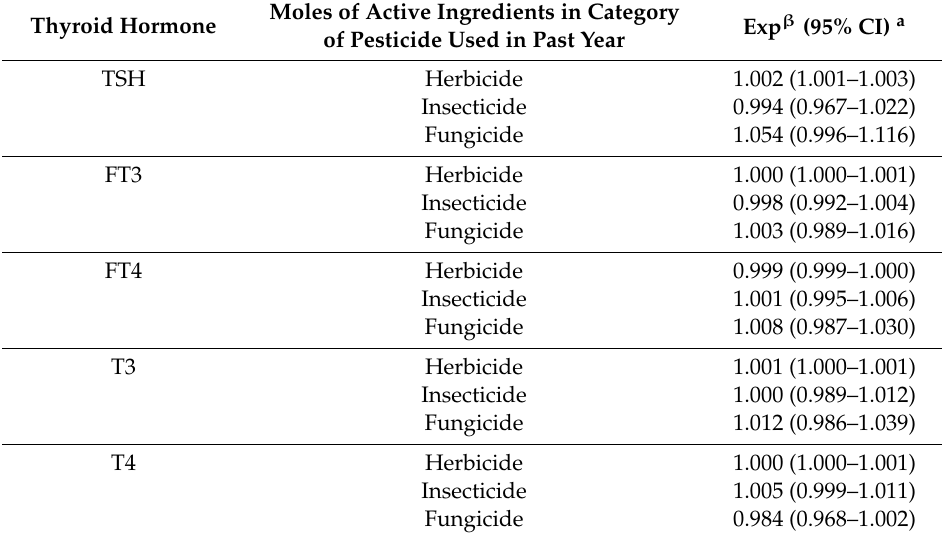
Table 4. Generalized linear regression models of thyroid hormone levels log(e) predicted by moles of di ff erent types of pesticides used in the past year for both conventional and organic farmers. Each row is a separate model.